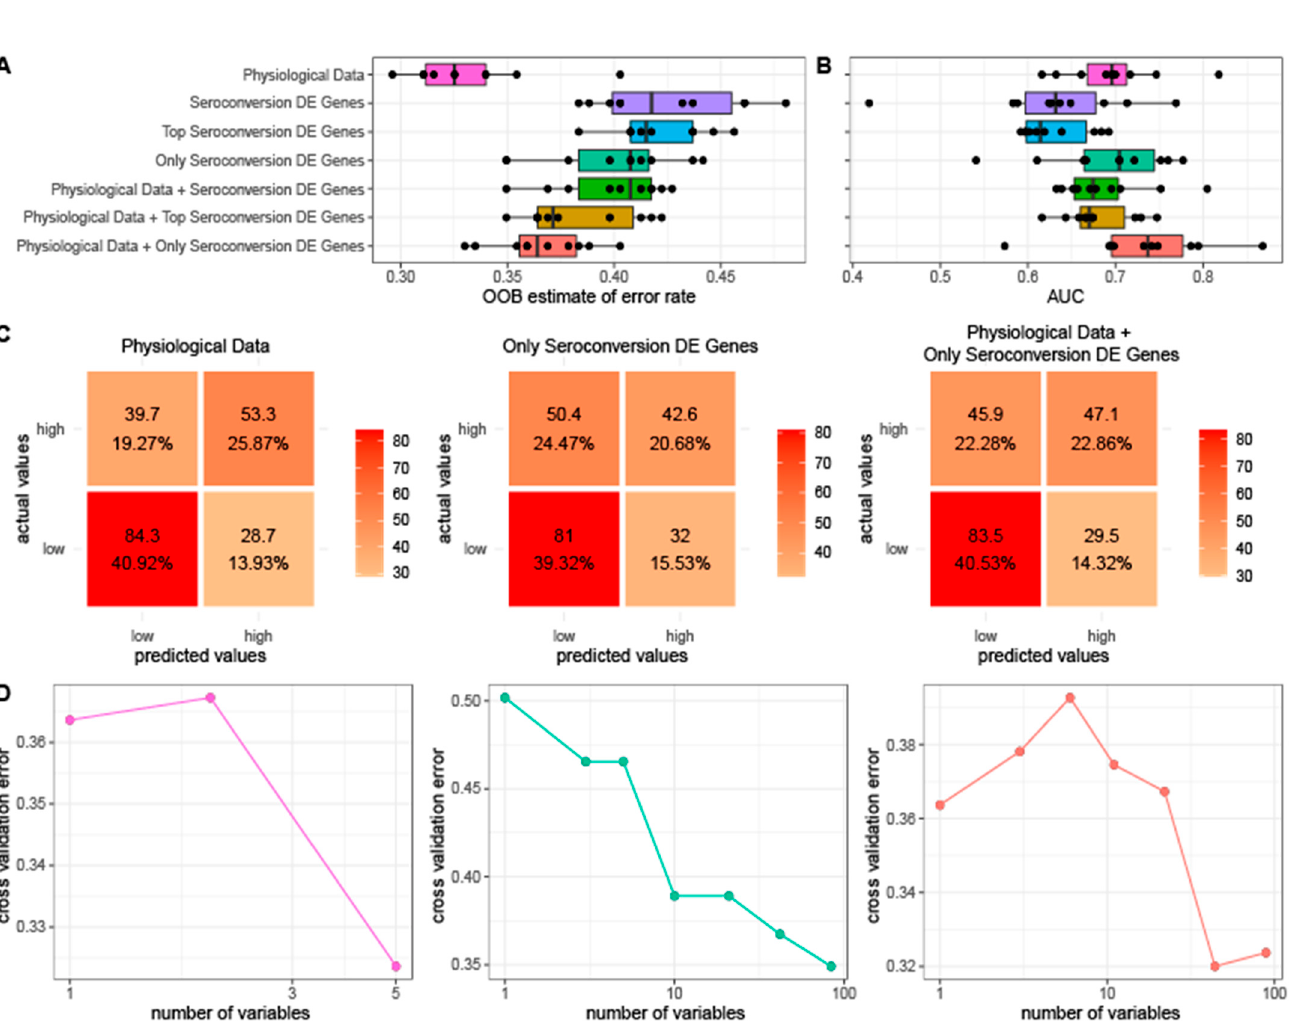
Figure 5. Prediction performance of random forest models generated using physiological and differential gene expression data to predict seroconversion. The average ( A ) out-of-bag (OOB) error rate and ( B ) average area under the curve (AUC) values generated using 10 iterations of random forest models constructed using a combination of physiological data, expression data, and both combined. ( C ) The confusion matrices displaying true and false positives and negatives for the random forest models using physiological data ( left ), expression data from the 84 exclusively differentially expressed genes as a function of seroconversion, ( middle ), and both combined ( right ). ( D ) A cross validation analysis plotting a varying number of variables for the physiological data ( left ), expression data from the 84 exclusively differentially expressed genes as a function of seroconversion ( middle ), and both combined ( right ) random forest models against the resulting cross validation